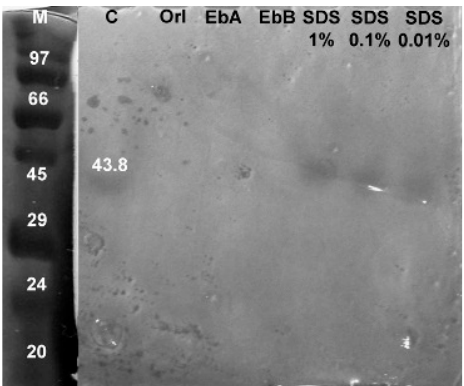
Figure 4. Zymogram of inhibition under native conditions on 10% polyacrylamide gels of lipolytic activity in juveniles of common snook C. undecimalis . M (molecular weight marker: phosphorylase 97 kDa, bovine serum albumin 66 Kda, Ovalbumin 45 Kda, carbonic anhydrase 29 Kda, trypsinogen 24 Kda, and SBTI 20 kDa). Control (lipases without inhibitor). Inhibitors: Orl (Orlistat), EbA (Ebelactone A), EbE (Ebelactone B), SDS (sodium dodecyl sulfate).